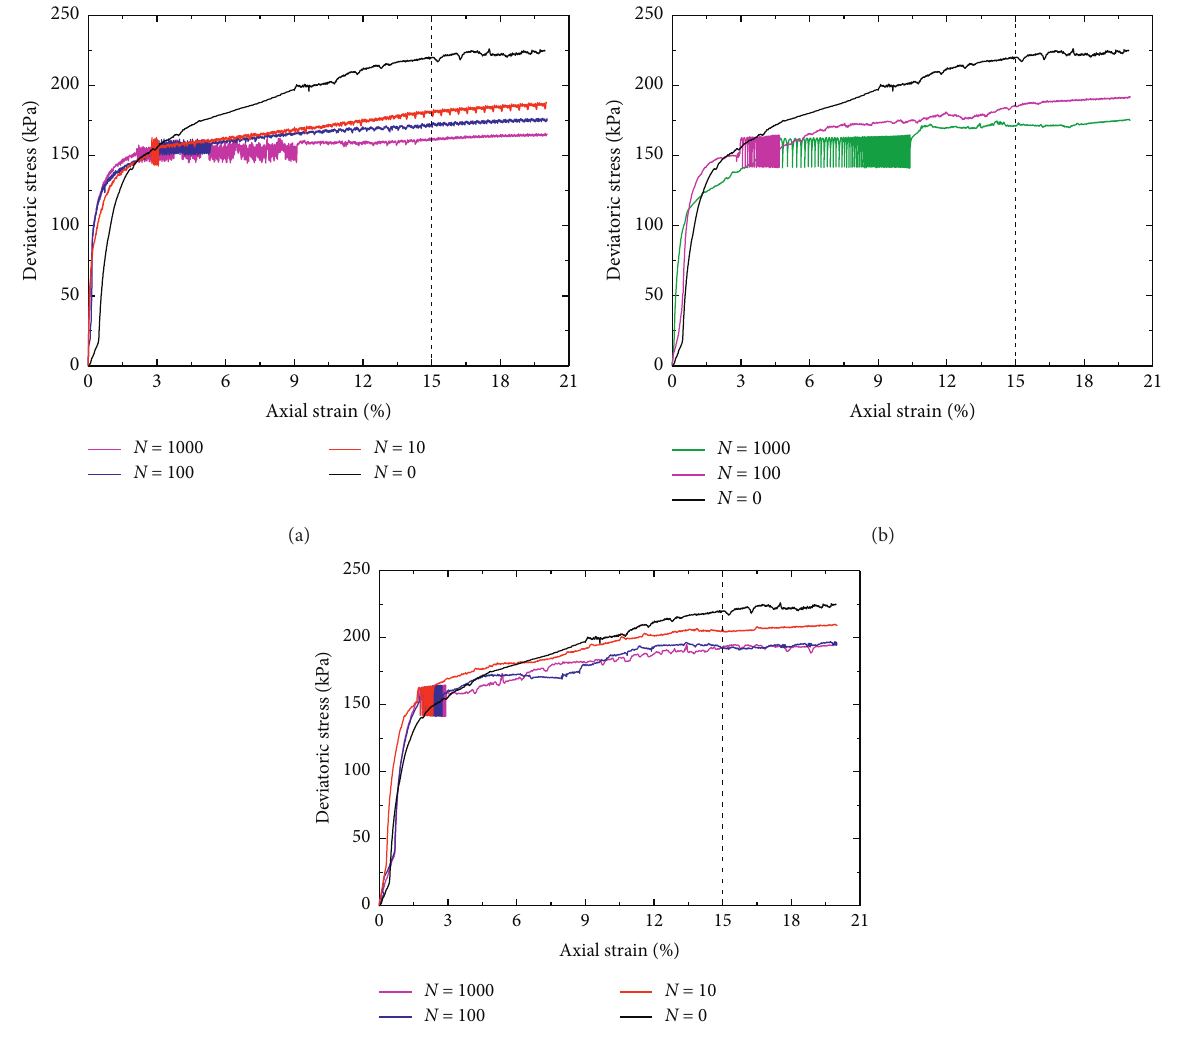
Figure 13: Deviatoric stress versus axial strain under a different number of cycles at a confining pressure of 100kPa. (a) T � 10s; (b) T � 60s; (c) T � 90s.